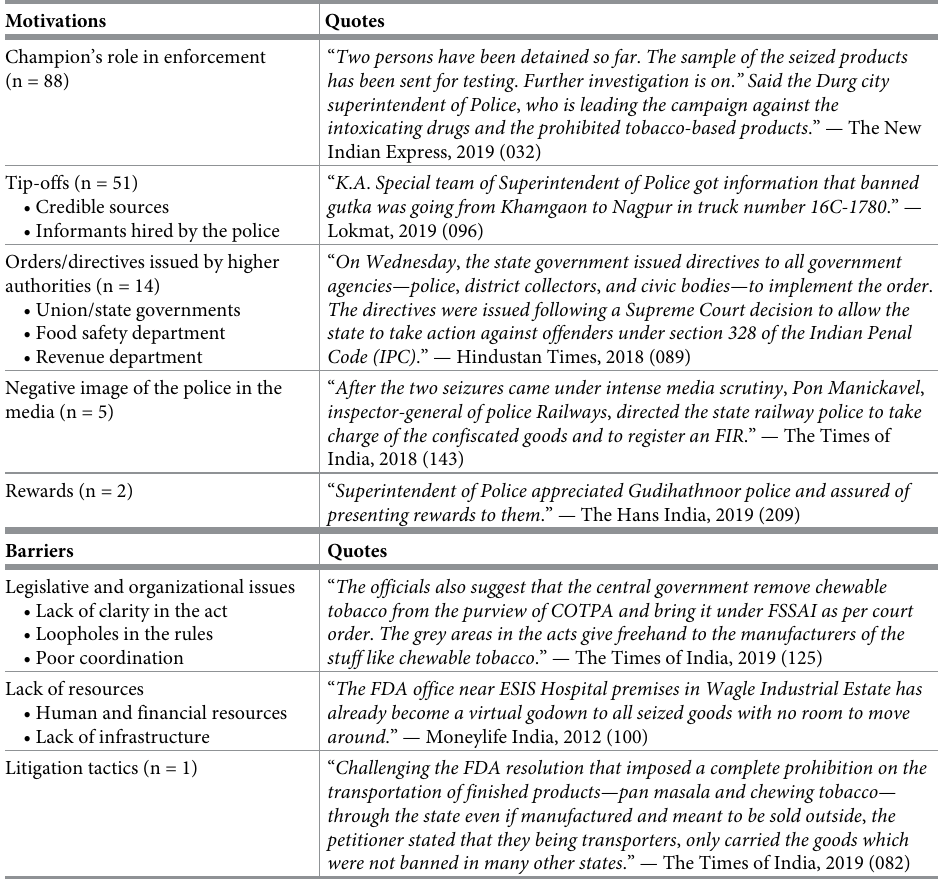
Table 4. Motivations and barriers while enforcing gutka ban in India.